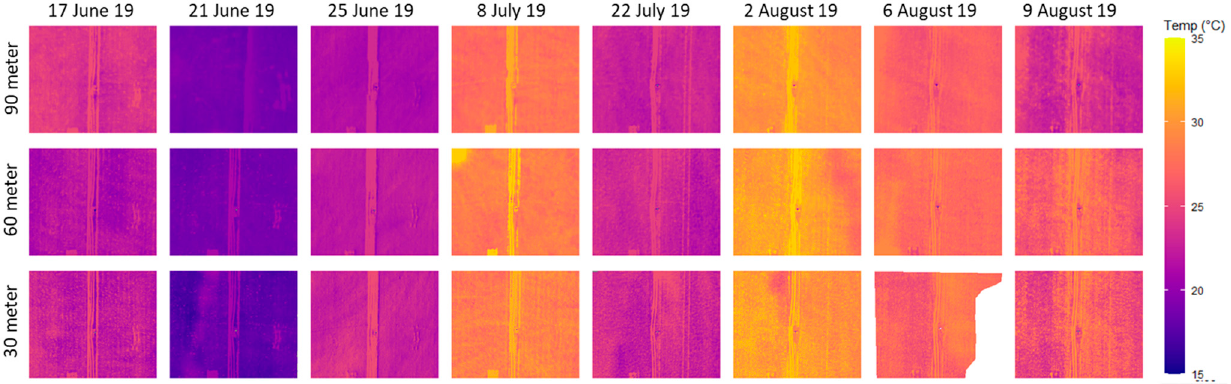
Figure 5. Surface temperature (°C) raster maps for each mission.